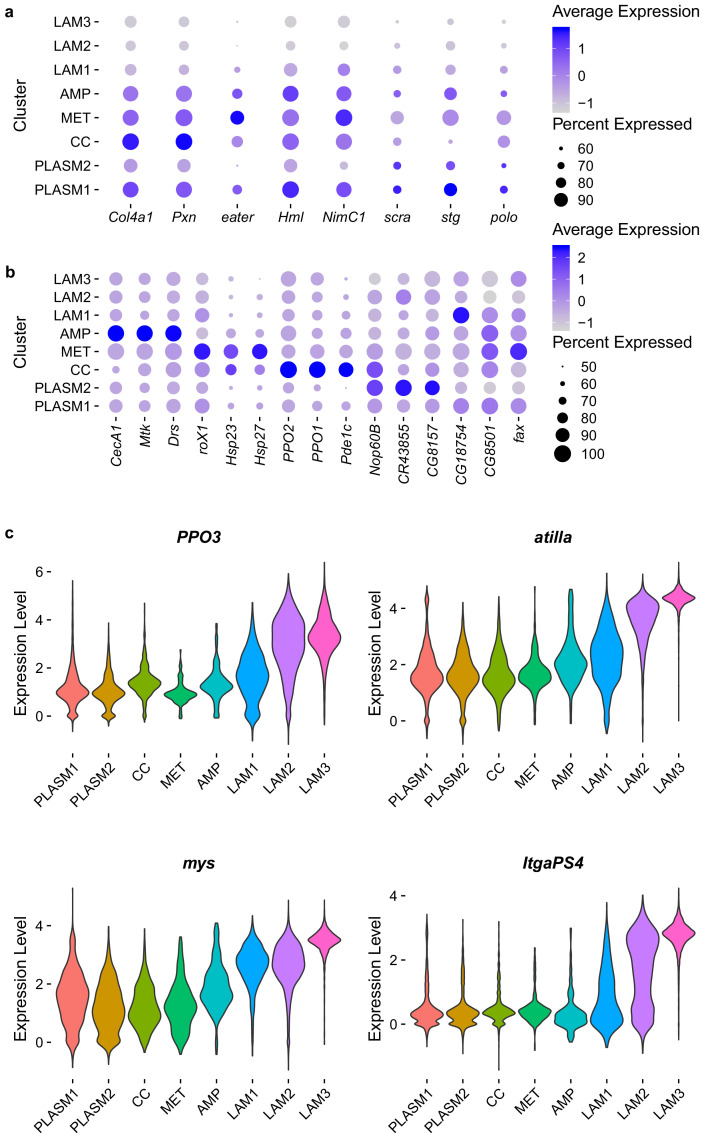
Expression levels (loge) of marker genes.(A) Relative level of expression of described plasmatocyte and cell cycle genes and (B) Relative level of expression most significant marker genes for the plasmatocyte and crystal cell clusters. The MAST test statistic was used to identify significantly upregulated markers in each cluster comparing the cluster of interest with cells in all other clusters. Percent of cells expressing genes are indicated by circle size. (C) Distribution of gene expression levels for described lamellocyte genes grouped by cluster identities.